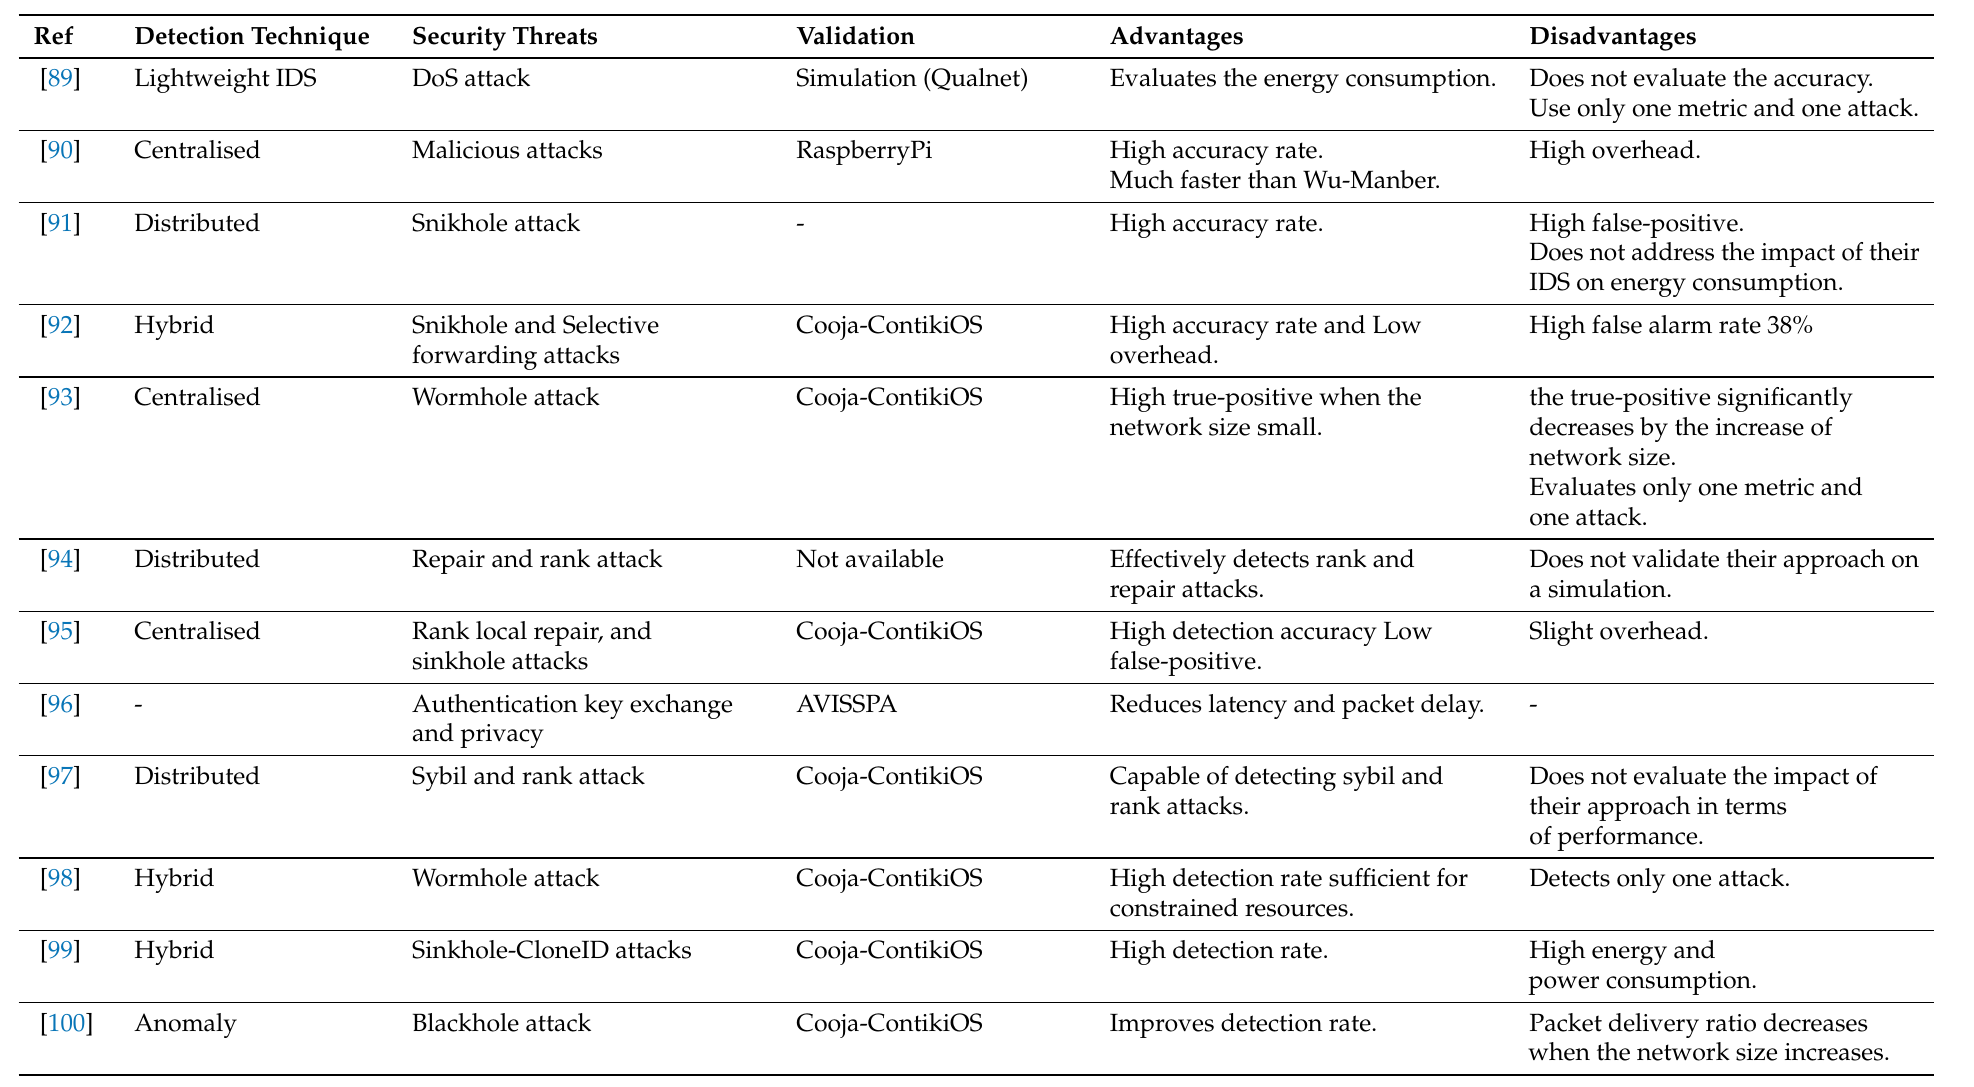
Table 3. Classification of intrusion detection systems for IoT network